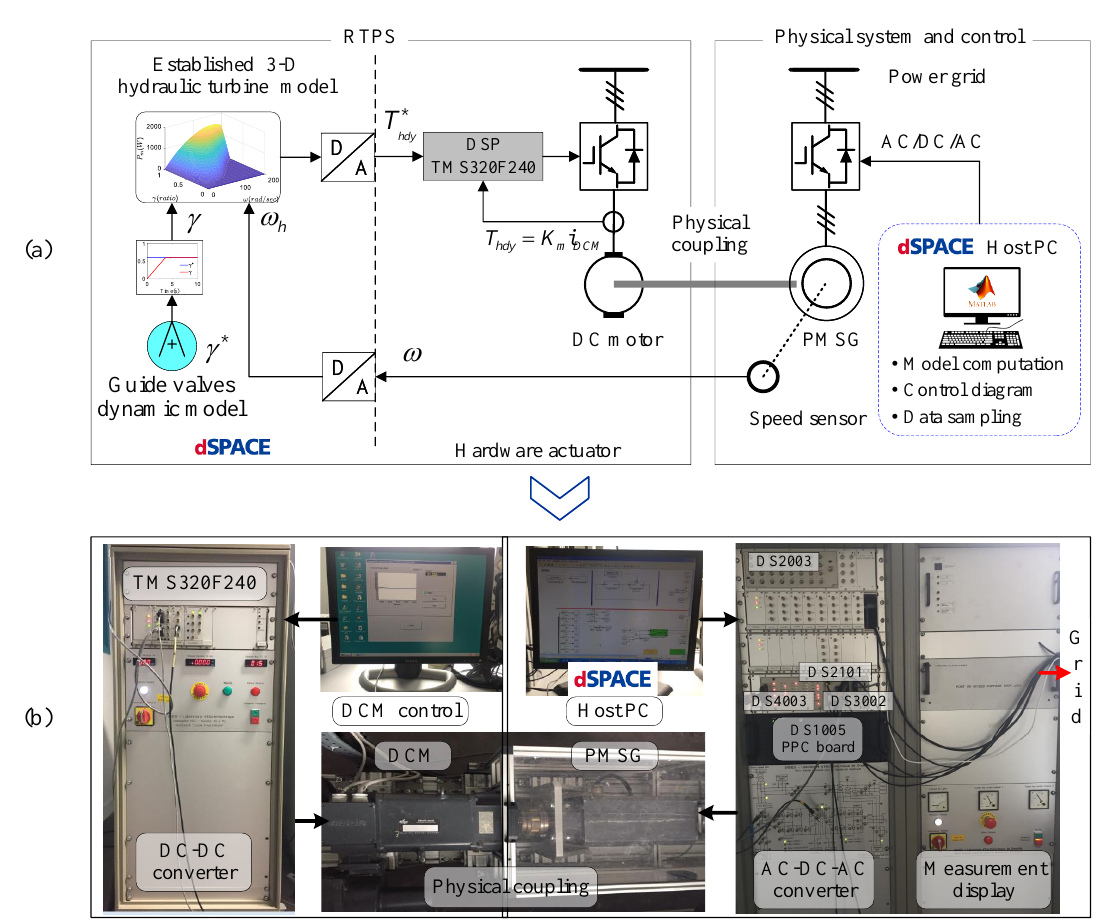
Figure 10. PHIL-based hybrid real-time VS-HEP simulation system, ( a ) global design diagram, with T hdy the emulated hydraulic torque, K m the torque constant, i DCM the direct current of DCM, ( b ) PHIL experiment